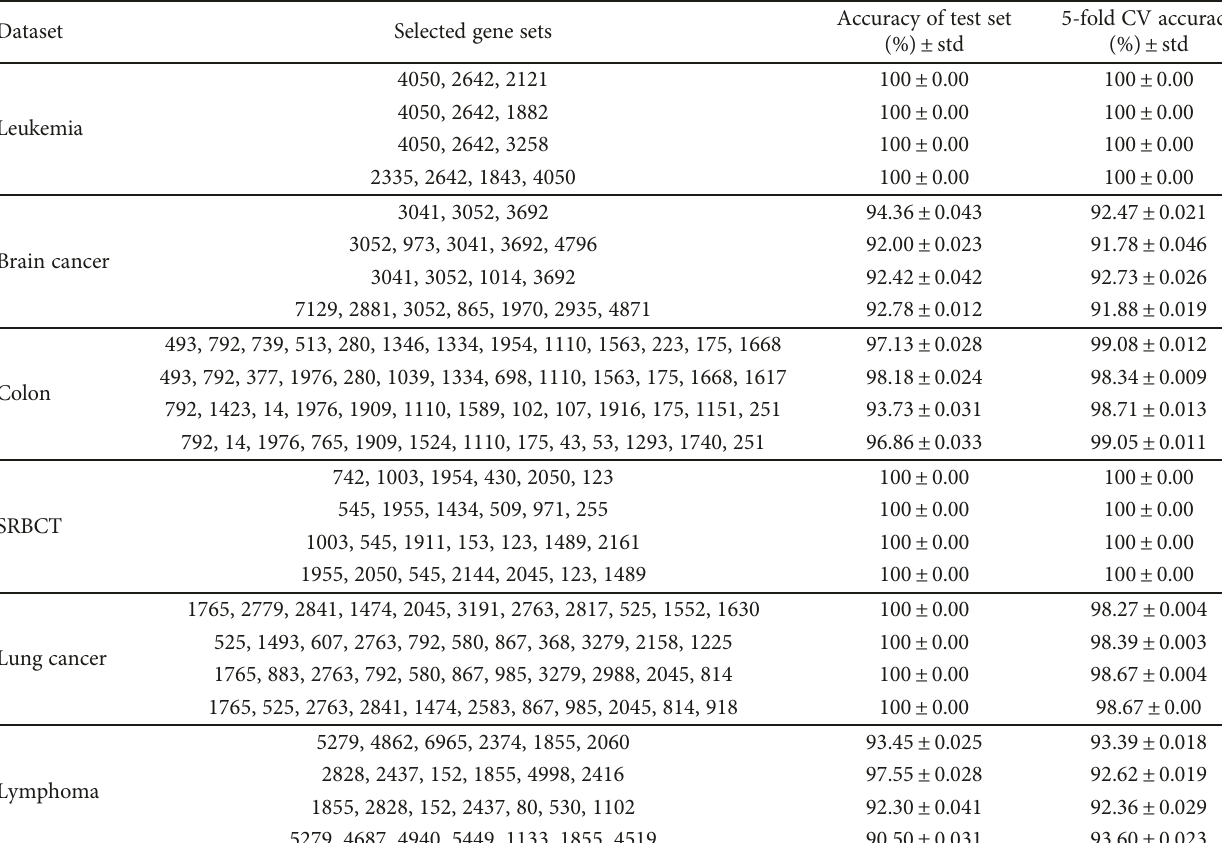
Accuracy of test